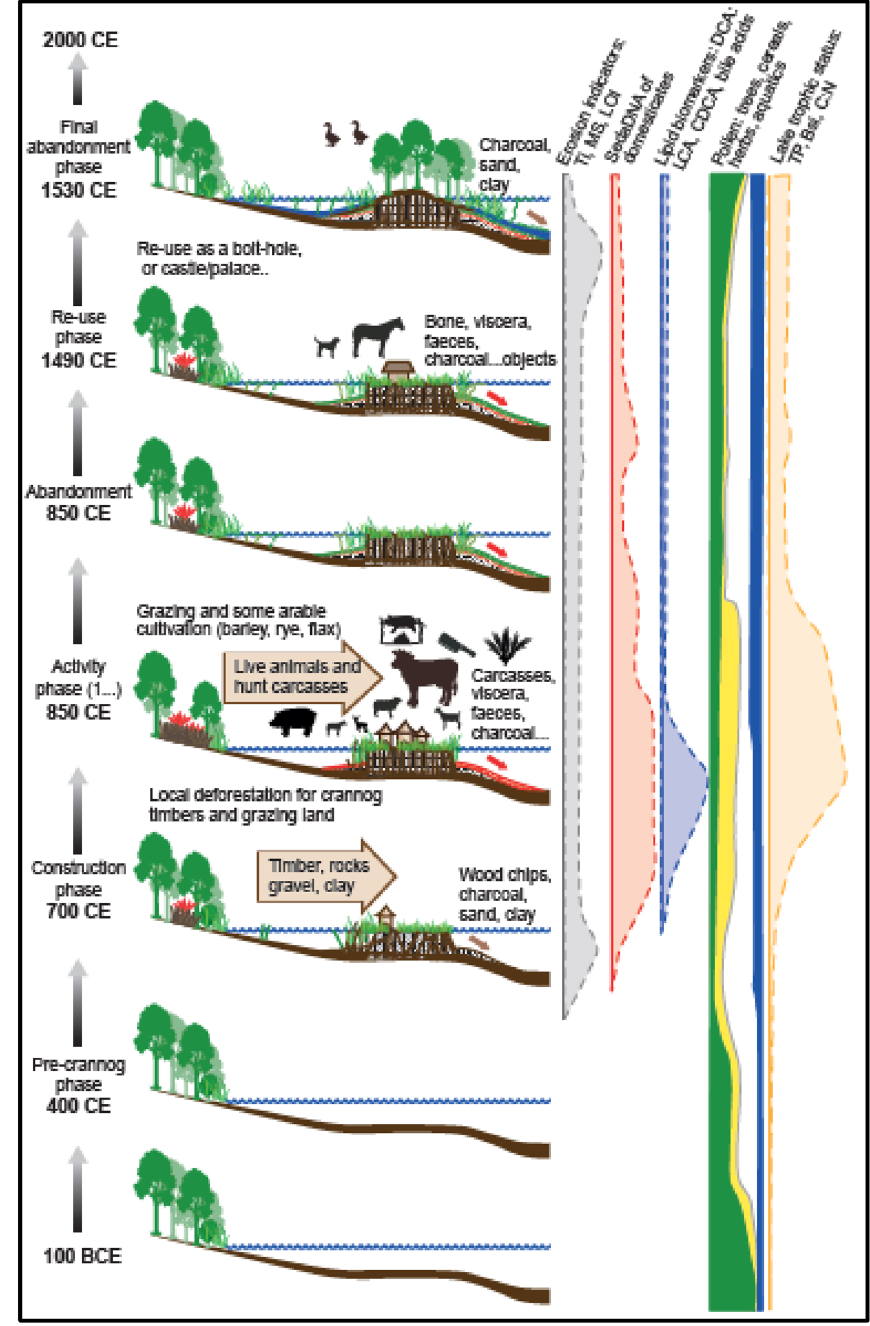
Figure 5. A diagrammatic representation of the chronological phases and multi-proxy results from the crannogs at Lough Yoan, including clastic proxies (MS is magnetic susceptibility), sedaDNA, lipid biomarkers, pollen and lake trophic status indicators